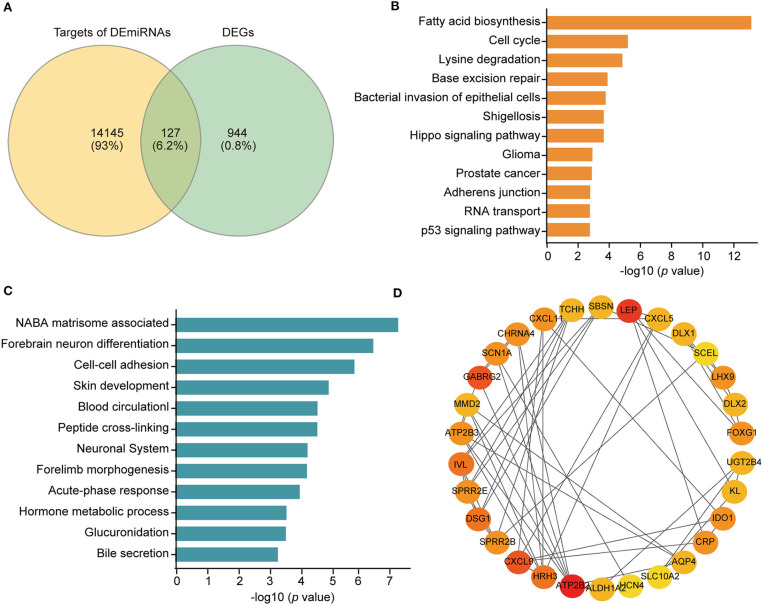
(A) Venn diagram depicting the overlap between the targets of the DEmiRNAs and DEGs. (B) Kyoto Encyclopedia of Genes and Genomes (KEGG) pathway enrichment of 14 DEmiRNAs based on the DIANA database. (C) Enriched ontology clusters of the 127 genes overlapping the targets of the DEmiRNAs and DEGs based on the Metascpae database. (D) The top 30 genes evaluated by connectivity degree in the PPI network of the 127 genes. The color from red to yellow represents the connectivity degree from high to low.